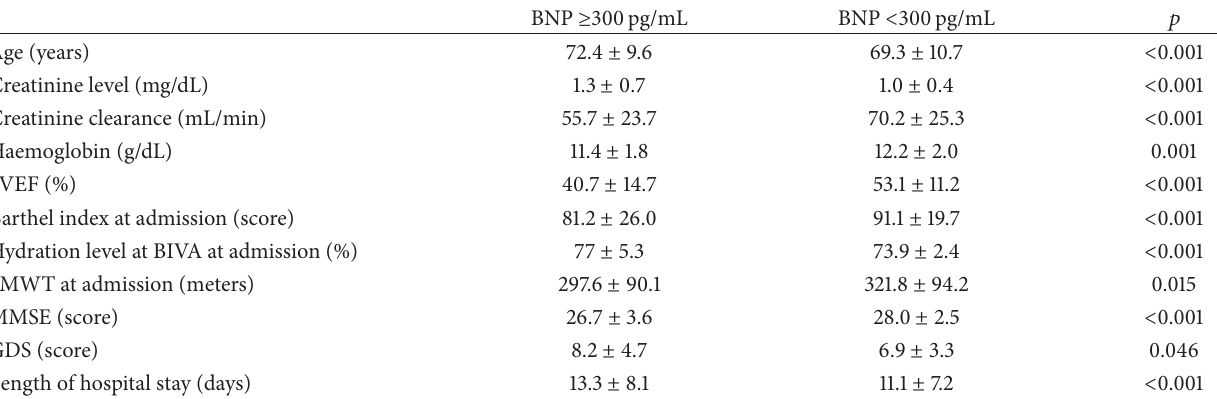
Table 2: Differences in clinical, laboratory, and instrumental parameters according to BNP